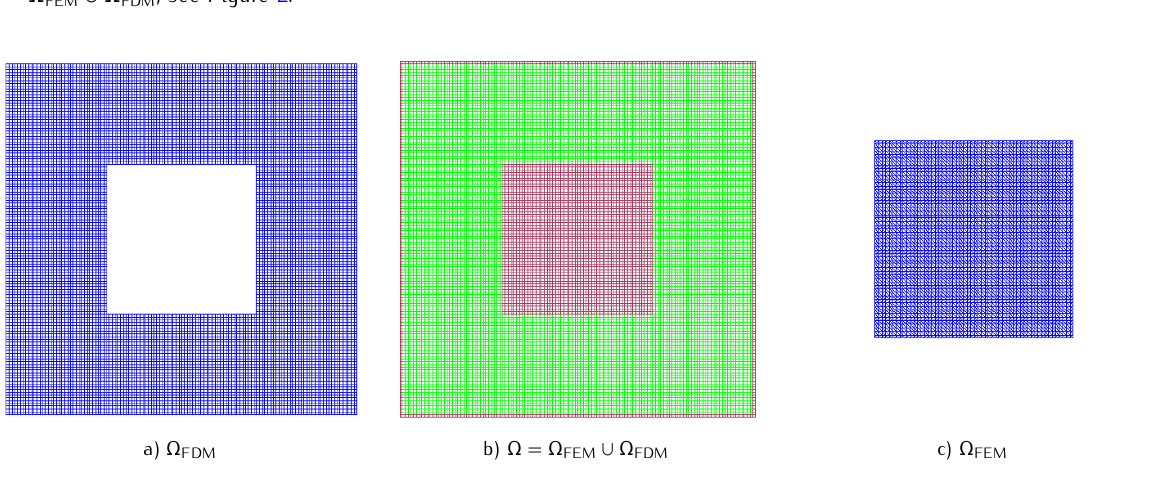
and ε ( x ) ≥ 1 for x ∈ Ω (cid:31) Ω FDM FDM